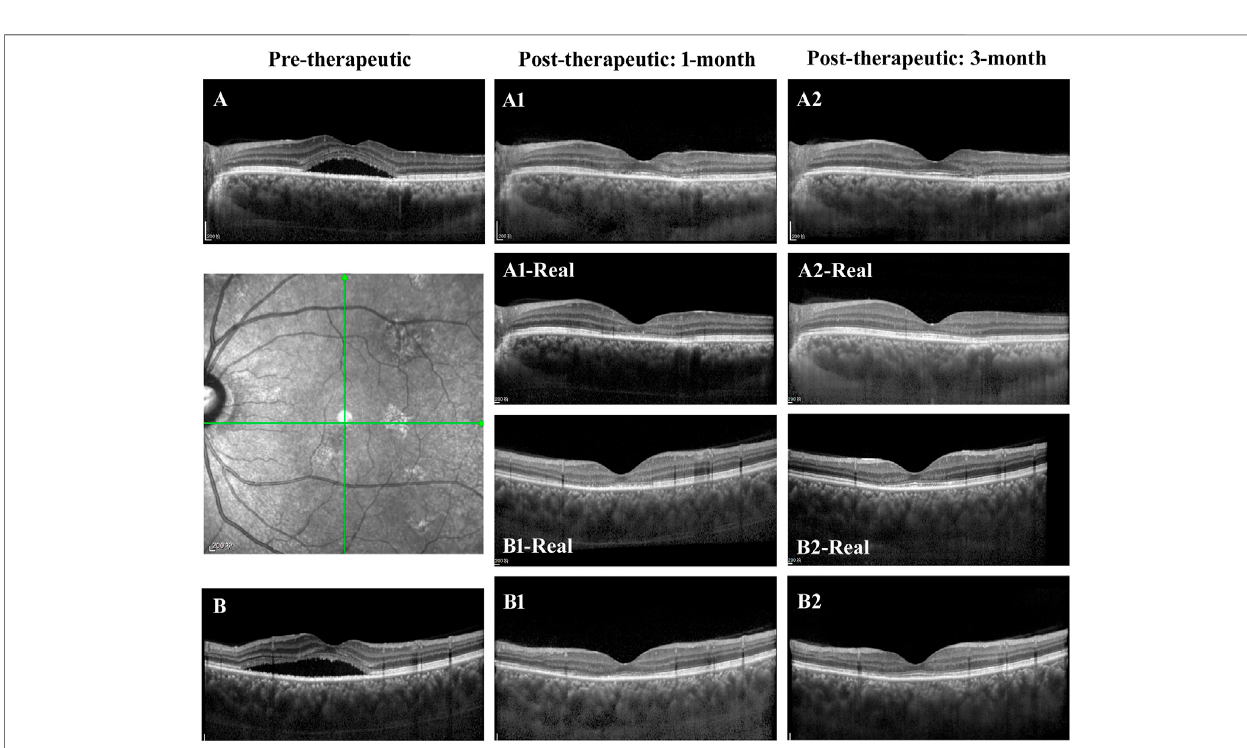
FIGURE8| Illustrations ofthesyntheticOCToftheGANmodel. (A , B) ThehorizontalandverticalOCTBscansofapatientwithCSC. (A1 , A2 , B1 , B2) Thesynthetic post-therapeutic images generated by the pix2pixHD. The images in the middle are the corresponding real images.